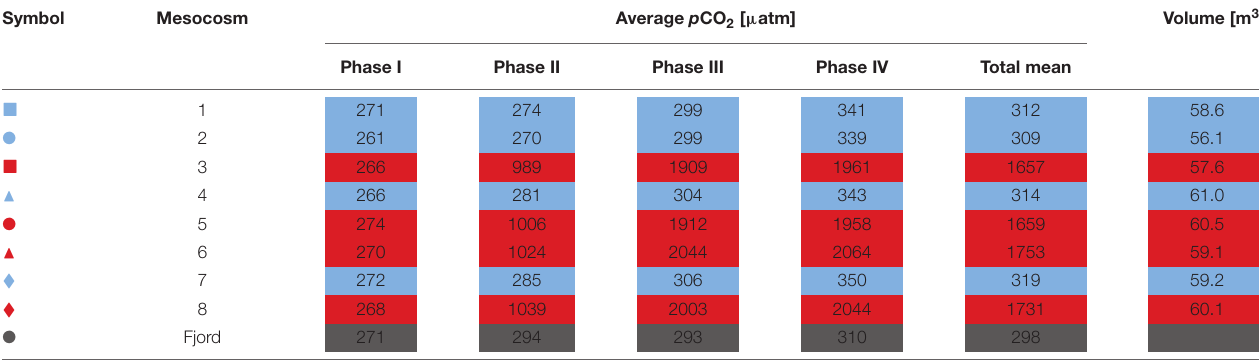
Fjord 271 294 293